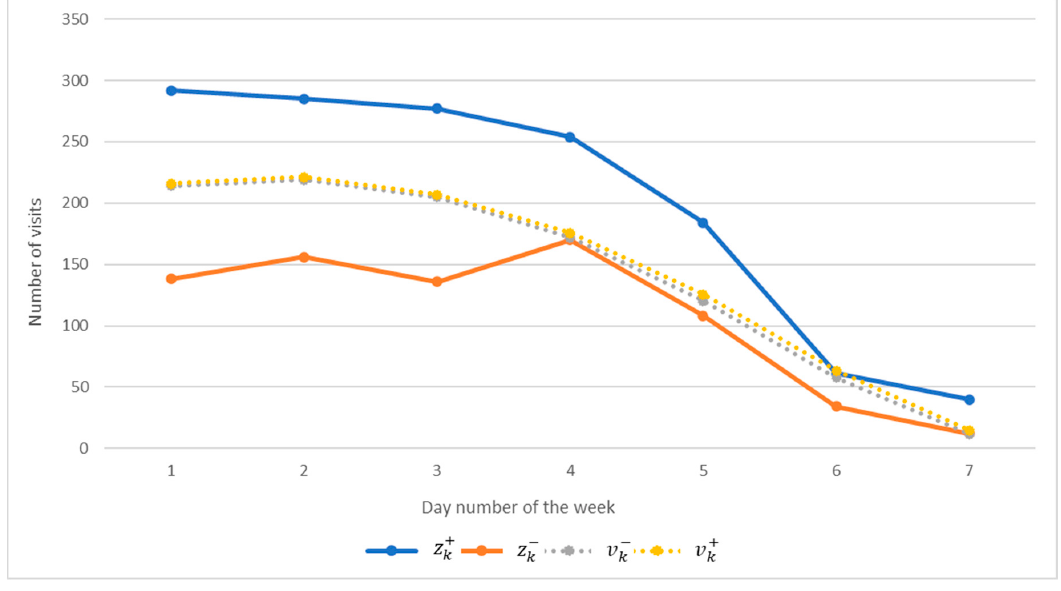
Figure 5. Results of prediction of user activity during the week.